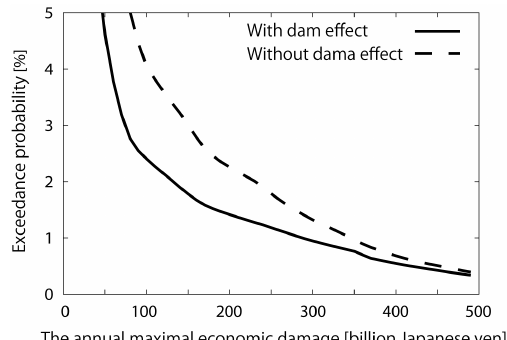
Figure 6. Flood risk curves in the Yura-gawa river basin with/without flood control by the Ohno dam (The solid line is a flood risk curve with dam control; and the broken line is a flood risk curve without dam